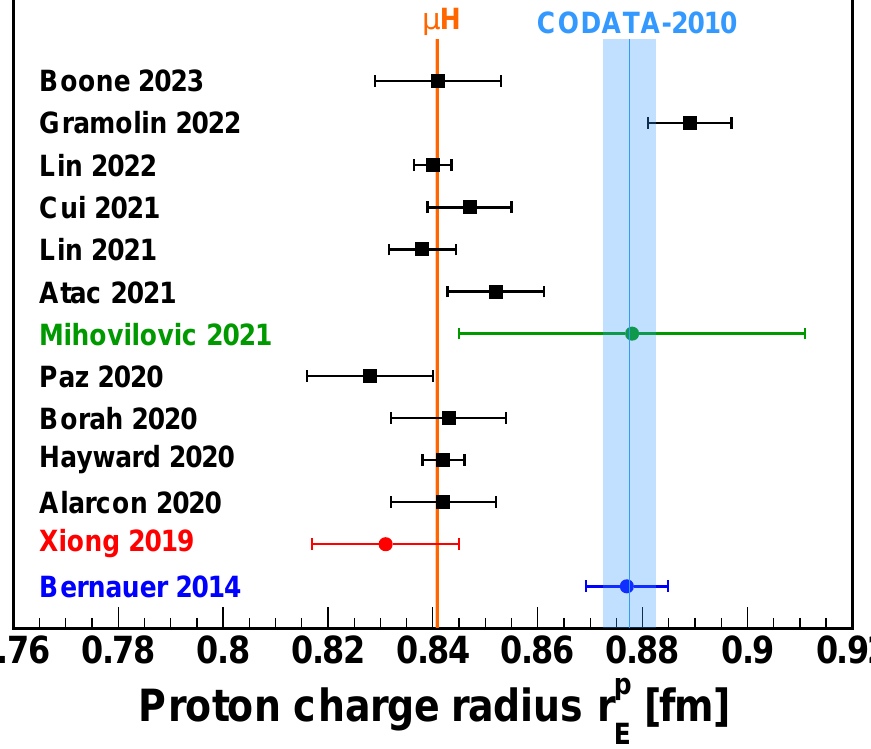
Figure 5. The proton charge radius extracted from a number of recent re-analyses [10,44,45,66,67,83–87] (black squares), as well as those from the original analyses of three recent unpolarized ep elastic scattering experiments (colored dots). The dark blue dot is for the Mainz 2010 experiment [2,88], the red dot is for the PRad experiment [3], and the dark green dot is for the Mainz ISR experiment [4]. The orange line and band (barely visible due to small uncertainty) correspond to the 2013 µ H spectroscopic measurement [20], and the light blue line and band correspond to the CODATA-2010 recommended value